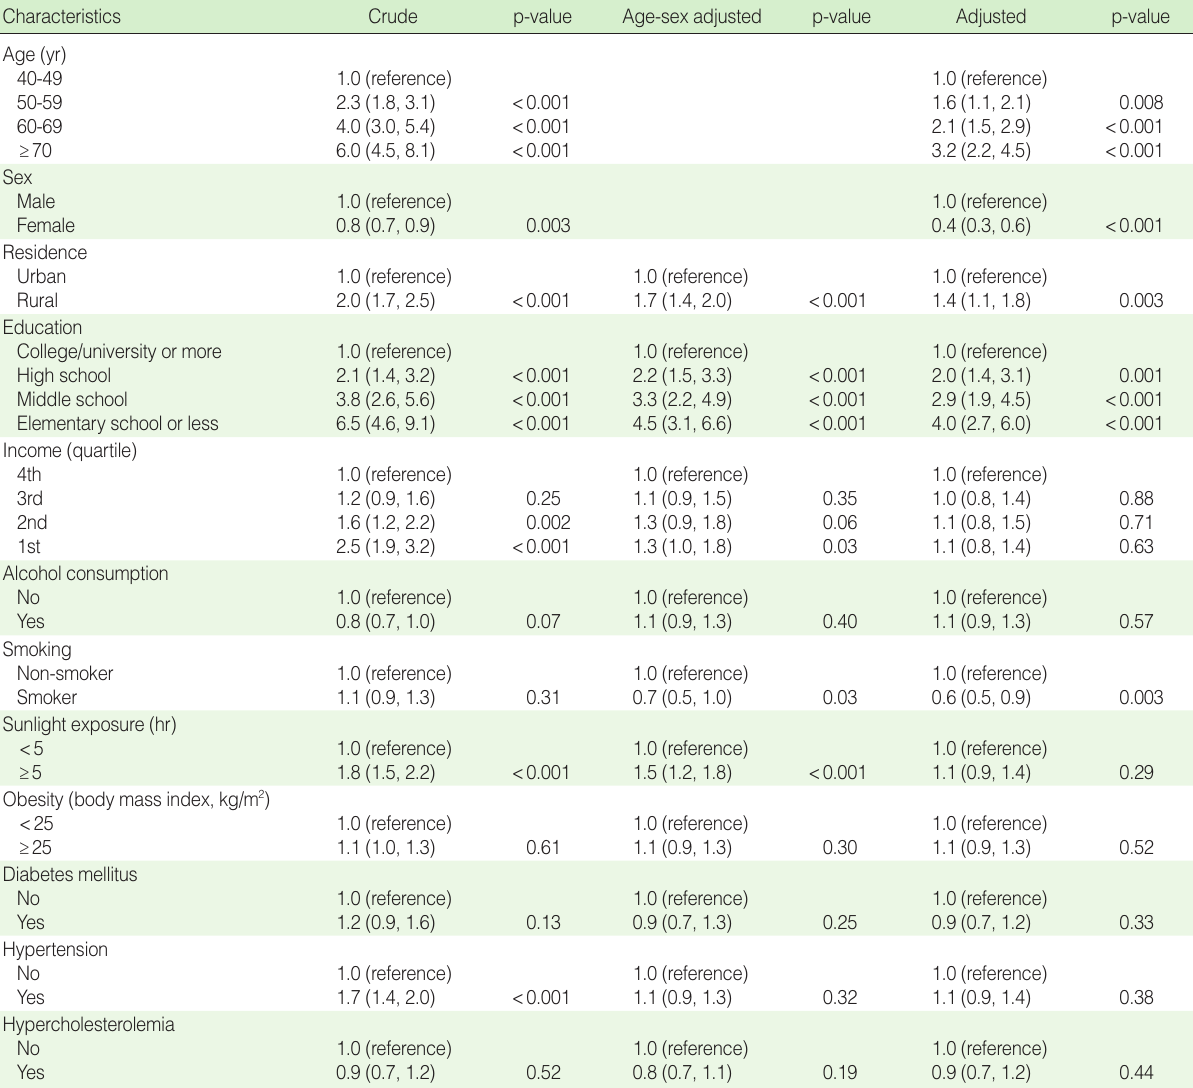
Table 4. The risk factors associated with any pterygium and a multivariate analysis of factors associated with any pterygium